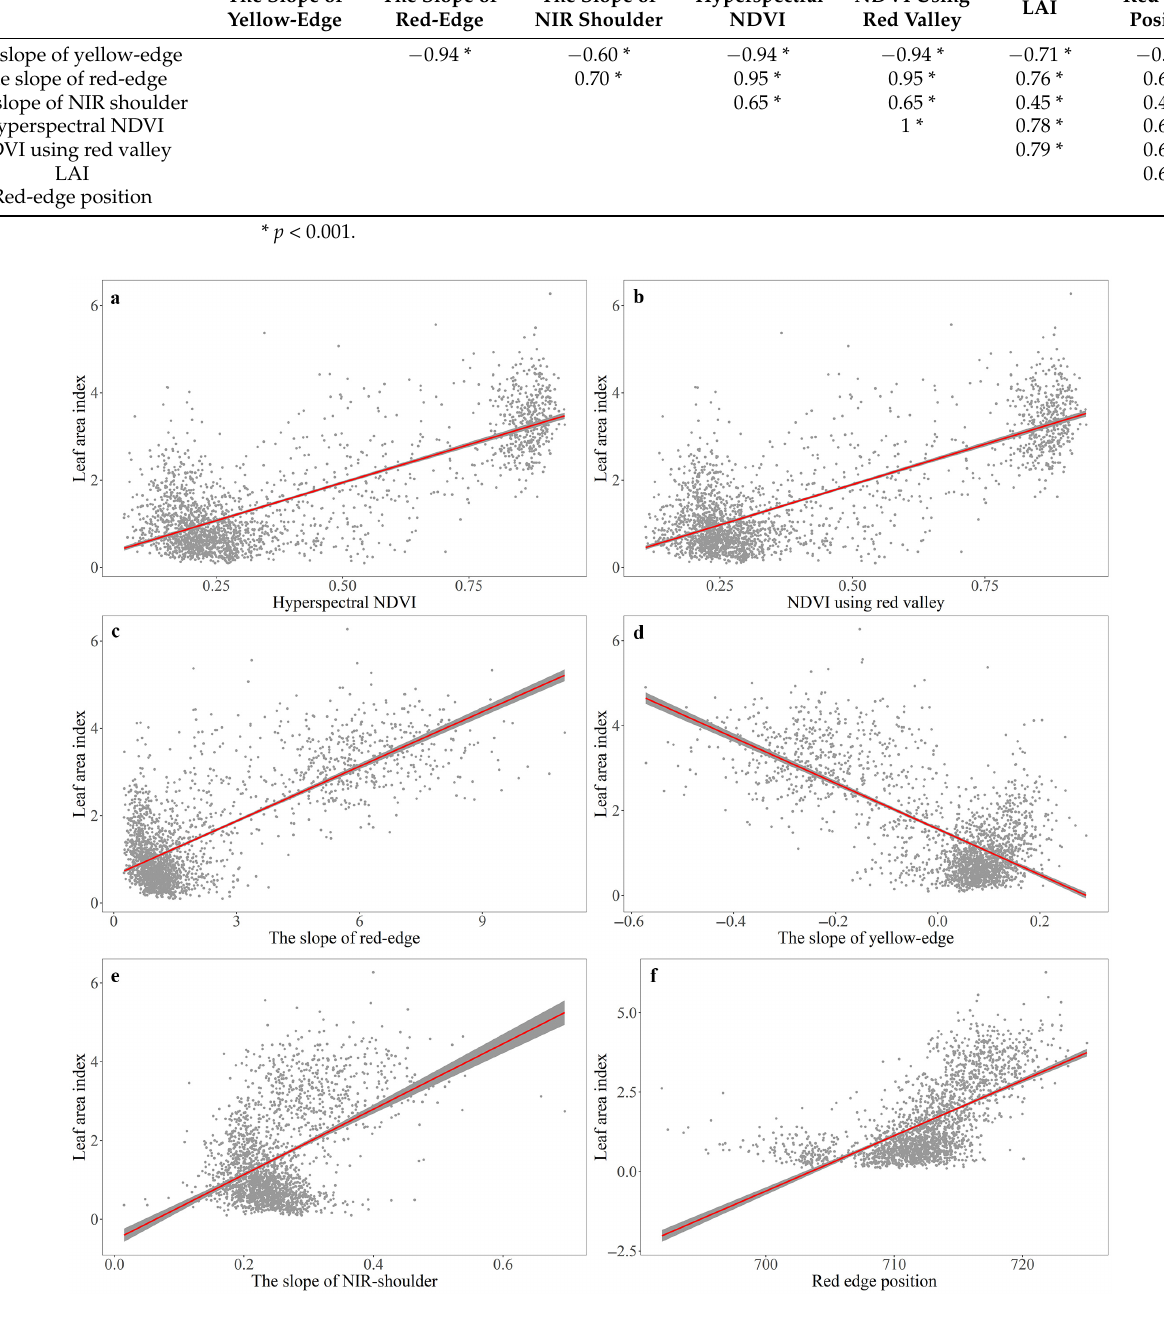
Figure A2. Linear regression models for LAI (leaf area index) estimation. The relation between LAI and hyperspectral NDVI ( a ), NDVI using red valley ( b ), the slope of red-edge ( c ), yellow-edge ( d ), the slope of NIR shoulder ( e ) and red-edge position ( f ).